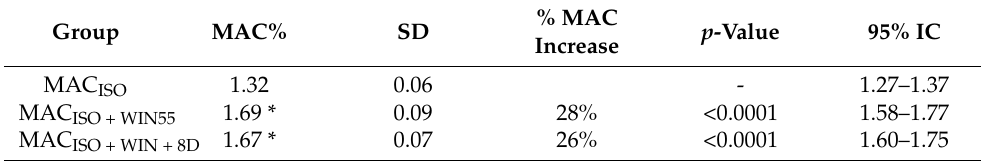
Table 2. Cardiorespiratory and temperature values of the different study groups. Value MAC ISO MAC ISO + WIN55 MAC ISO + WIN + 8D Hearth rate (bpm) 401 ± 8 403 ± 7 403 ± 9 Mean arterial blood 93 ± 8 pressure (mmHg) Temperature ◦